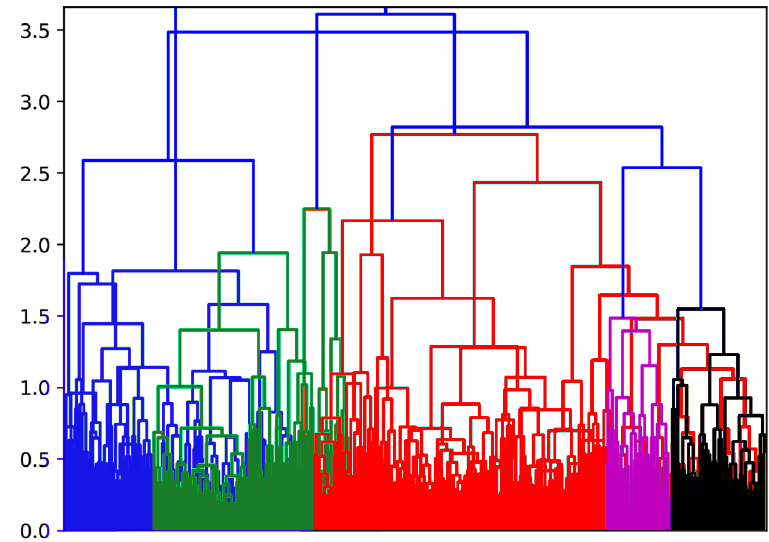
Figure 9. Dendrogram provided by the hierarchical clustering algorithm.